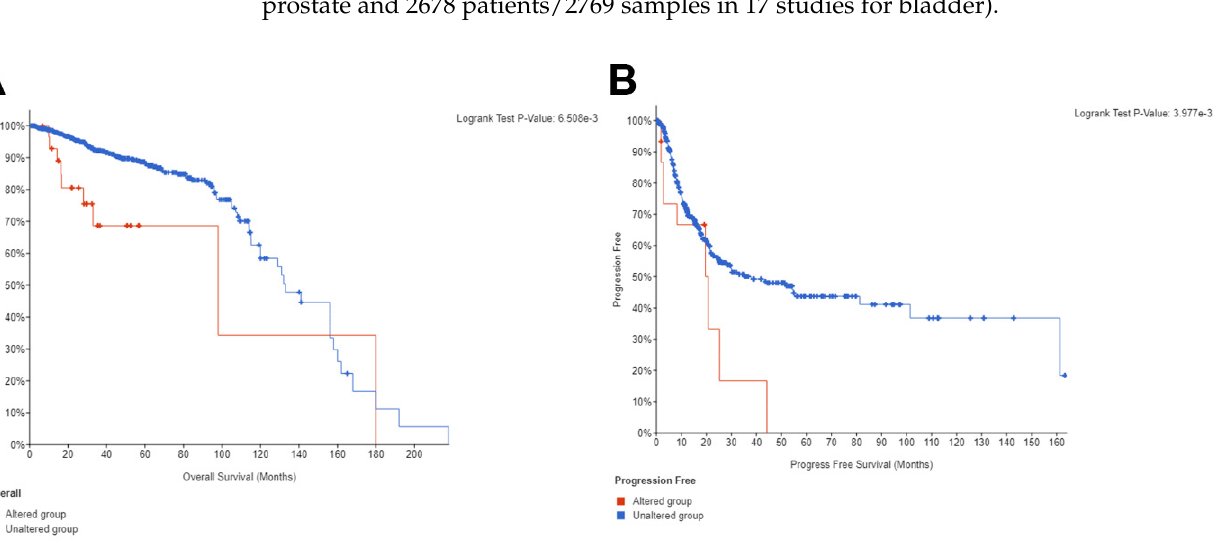
Figure 4. Expression of ARPC1B in PCa cell lines. ( A ) Western blot analysis of ARPC1B expression in PCa cell lines: RWPE1, PC3, C4-2, DU145, LNCaP, and VCAP. ( B ) Knockdown of PC3 and DU145